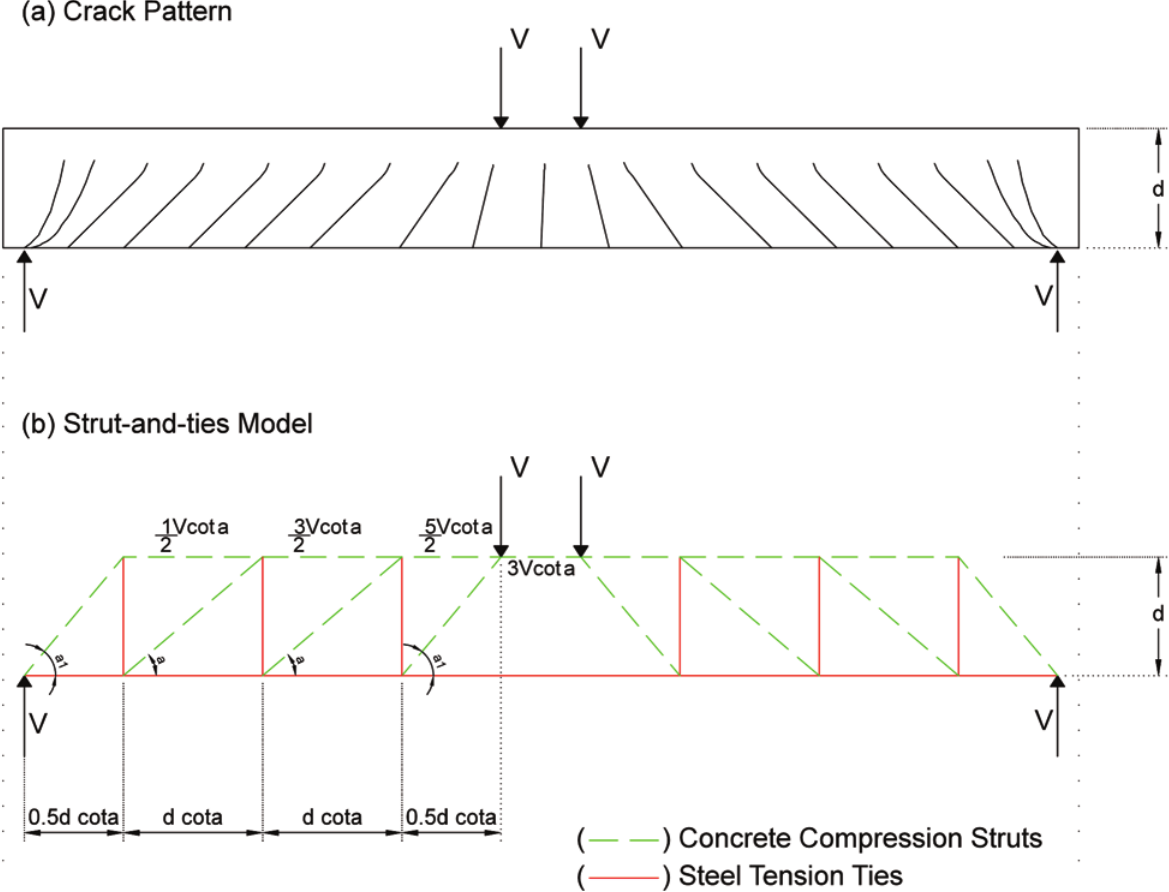
Figure 1 Struts-and-ties model of a concrete beam with bottom longitudinal rebars and stirrups resisting shear and